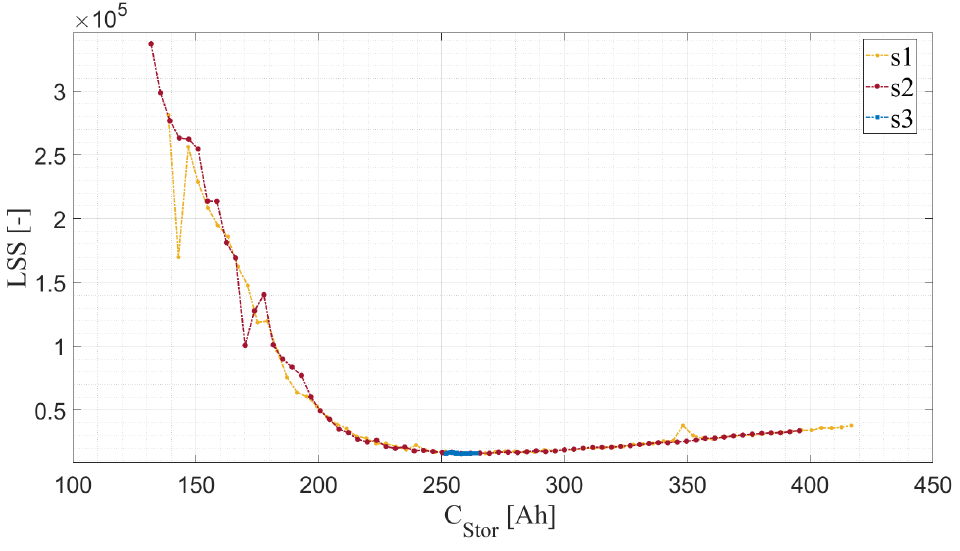
Figure 6. Finding the local minimum of the parameter C Stor after the three optimization